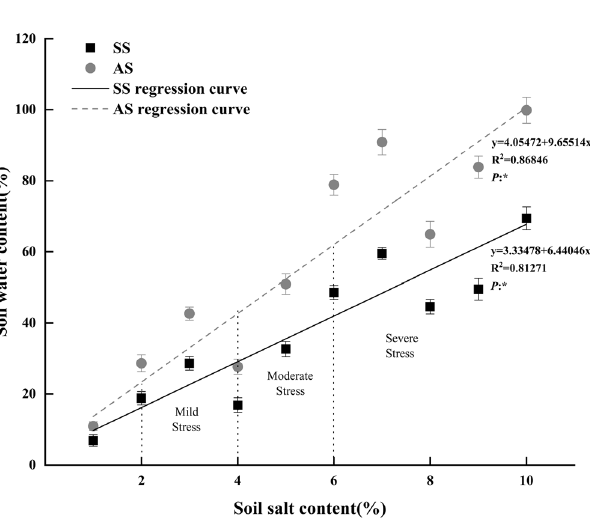
Figure 6. Linear regression curve of the soil salt content, and soil water content. * Means a significant difference at P < 0.05 (n =